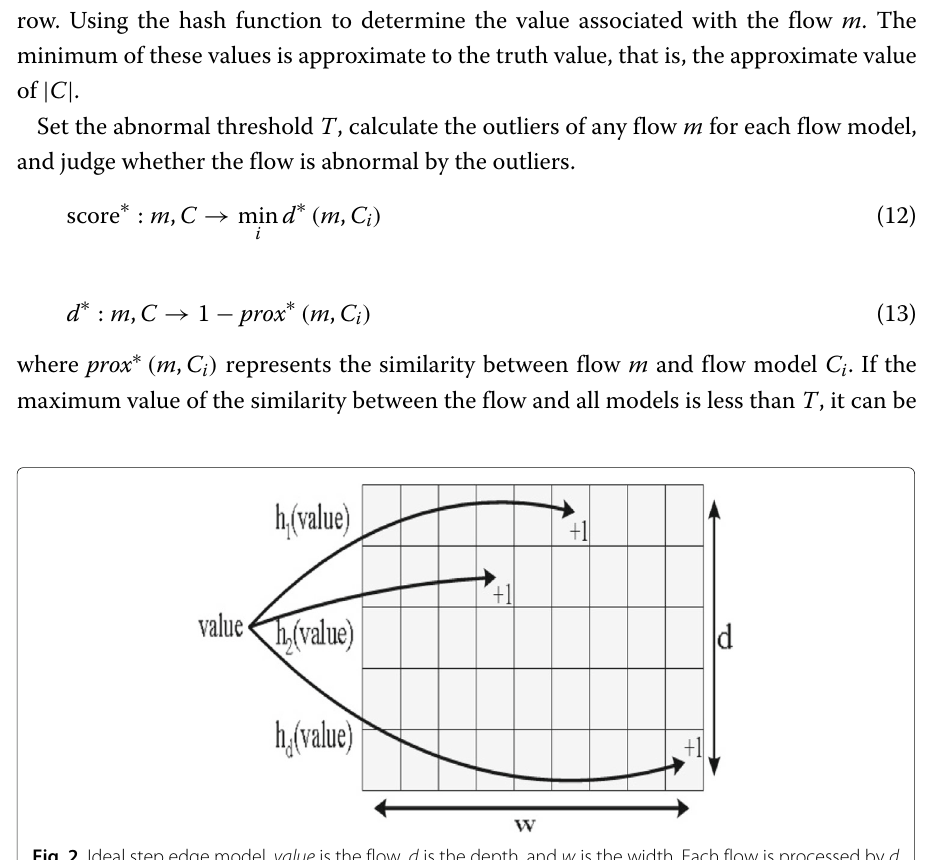
value is the flow, d is the depth, and w is the width. Each flow is processed by d hash functions h i to determine location p i = h i ( value ) , i ∈ [1, d ], p i ∈ [0, w − 1]. For any flow m , apply hash mapping and apply the result value to the position in the corresponding row. Using the hash function to determine the value associated with the flow m . The minimum of these values is approximate to the truth value, that is, the approximate value of | C |